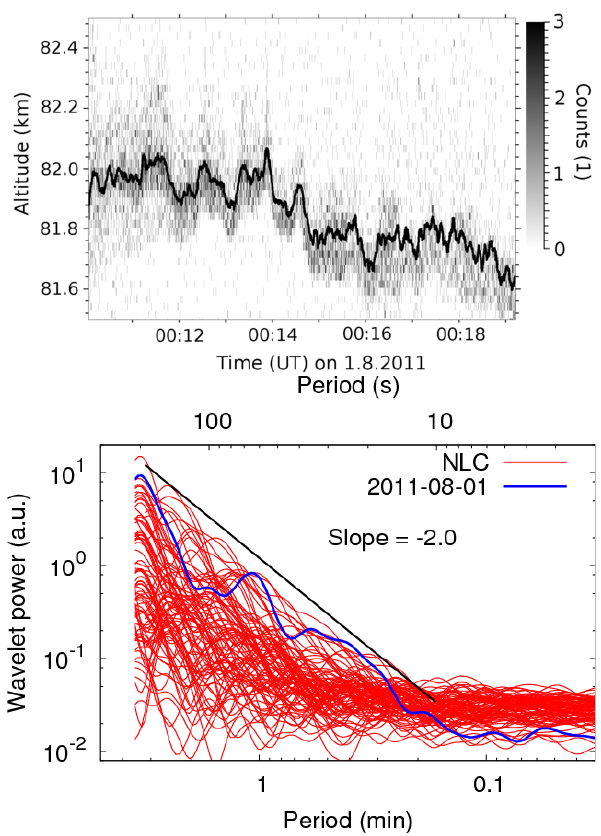
Fig. 9. Top: example lidar single-shot acquisition (LISA) raw data file, time resolution 0.33s (10 shots) on 1 August 2011, 00:10:04– 00:20:10UT. The black dots indicate the average NLC altitude smoothed by a 3.6s (110 shots) window. Bottom: wavelet spectra of NLC altitude variations in 2011 (91 time series of 10min dura- tion each). The black line indicates a slope of − 2 and the spectrum corresponding to the example shown is